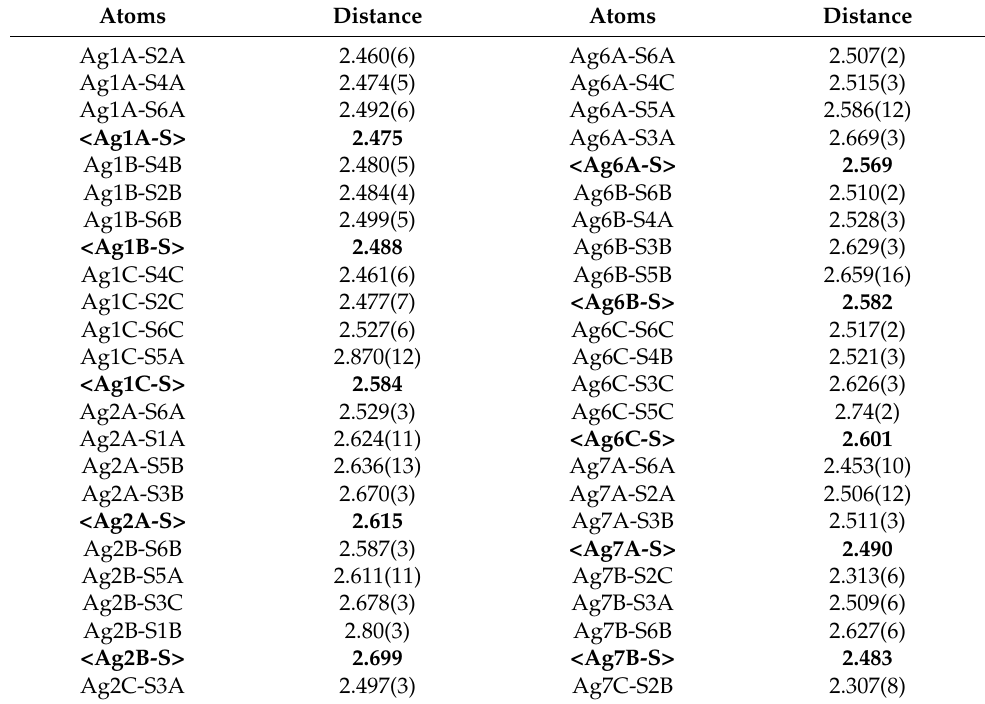
Figure 2. Left: Portion of the crystal structure of spryite at room temperature highlighting the disorder between the M 1 and M 2 positions (As 3+ , As 5+ and Ge 4+ ) at room temperature. In light blue the M 1 tetrahedron (As 5+ and Ge 4+ ) and with a red sphere the M 2 atom (As 3+ ). Right: The crystal structure of spryite at 30 K; Ag and S atoms are given as white and yellow spheres, respectively. Light blue and red tetrahedra are filled by As 5+ and Ge 4+ , respectively, whereas green polyhedra are filled by As 3+ . The unit cell and the orientation of the structure are outlined. Table 3. Selected bond distances [Å] and angles (°) for spryite at 30K.